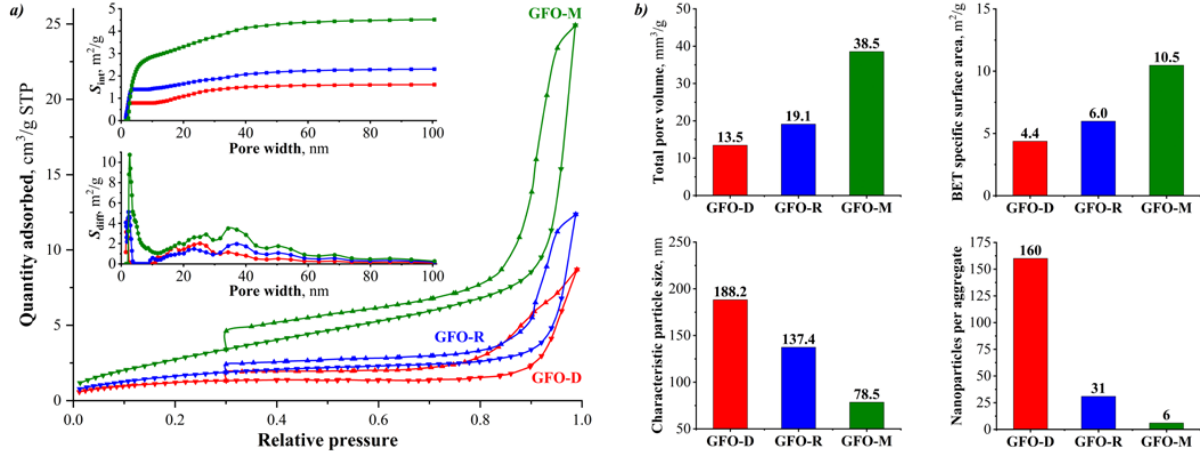
Figure 5. ( a ) Low-temperature nitrogen adsorption-desorption isotherms of the heat-treated products of co-precipitated hydroxides. The insets show the pore width distributions in these products: S int = integral surface area, S diff = dif- ferential surface area; ( b ) Comparison of the results of adsorption-structural analysis of the heat-treated products of co-precipitated